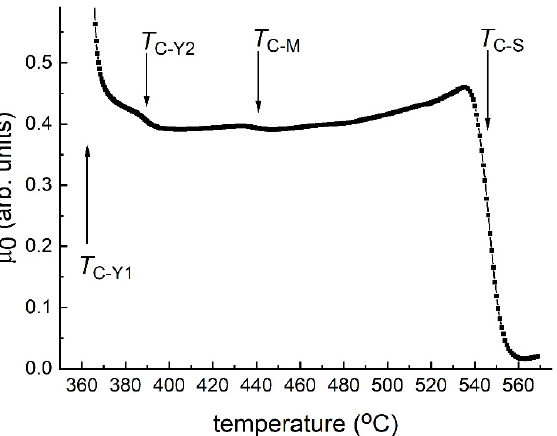
Figure 2. An enlarged area of the thermograms μ 0 ( T ) of hexaferrite Ni 2 -Y. Our estimates of the phase transition temperatures of Ni 2 -Y hexaferrite and the tran- sition temperatures for other compositions of the Ni 2-x Cu x -Y system are given in Table 2. Note that the temperature T C-S of the spinel impurity phase in Ni 2 -Y hexaferrite (546 °C) is less than the Curie temperature of magnetite and nickel ferrite (585 °C) [1], and the tem- perature T C-M is close to the Curie temperature of Ba-M hexaferrite (450 °C) [1]. The T C-Y1 temperature is noticeably lower than the literature data on the T C of the Ni 2 - Y hexaferrite. According to [11,22], this temperature is 390 °C and 387 °C, respectively. It should be noted that the temperature of the feature marked by us as T C-Y2 on the depend- ence μ 0 ( T ) is close to these estimates. The obtained data can be explained by the fact that the transformation of the type of magnetic ordering with decreasing temperature from T C in Ni 2-x Cu x -Y hexaferrites in the range of compositions up to x = 1.2 occurs as follows. It is known that the EMP anisotropy of these materials is due to the dipole contribution to the energy of magnetocrystalline anisotropy (MCA) [1]. In the temperature range near T C , the values of magnetization are low. Therefore, at temperatures from T C-Y1 to T C-Y2 , the presence of other contributions to the MCA energy can change the type of magnetic order from EMP to easy magnetization axis (EMA) or easy magnetization cone (EMC) ordering. An increase in the concentration of Cu 2+ ions leads to a decrease in the temperatures of all phase transitions. The closest value to our estimate T C-Y = 320 °C was obtained for Cu 2 -Y hexaferrite in [36]. The temperature value T C-S obtained by us at x = 2.0 is also close to the Curie temperature of copper ferrite T C = 455 °C [1]. Table 2. Phase transition temperatures of the hexaferrites Ni 2-x Cu x –Y system determined from the derivatives d ( μ 0 ( T ))/ dT minima. Concentration, x